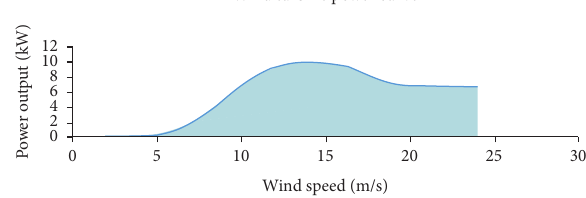
Figure 4: Power curve of the selected wind turbine [28].